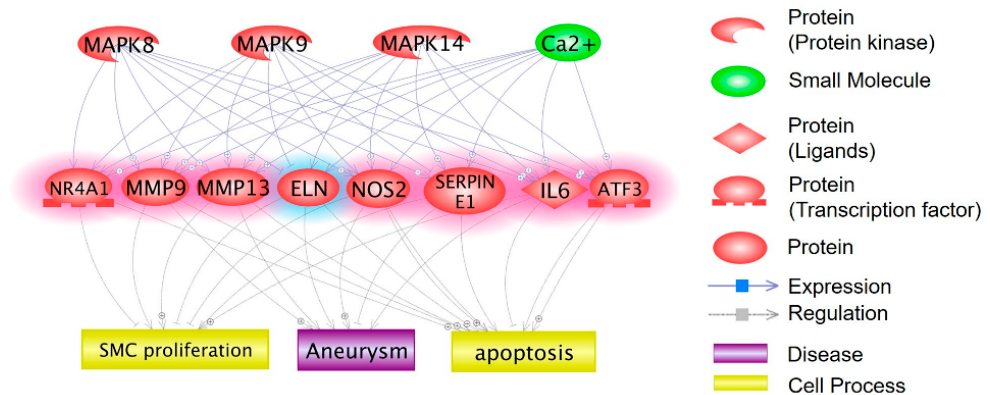
Figure 1. Molecular networks associated with mitogen activated-protein kinases (MAPKs) (JNK and p38), apoptosis, and aneurysm. The 91 differentially expressed genes (DEGs) dysregulated in rat aortic smooth muscle cells (RASMCs) treated with cyclic mechanical stretch (CMS) were subjected to bioinformatics analyses to identify genes related to both the JNK and p38, apoptosis, and aneurysm. The regulation between the MAPKs, dysregulated genes, apoptosis, and aneurysm is shown in the network.